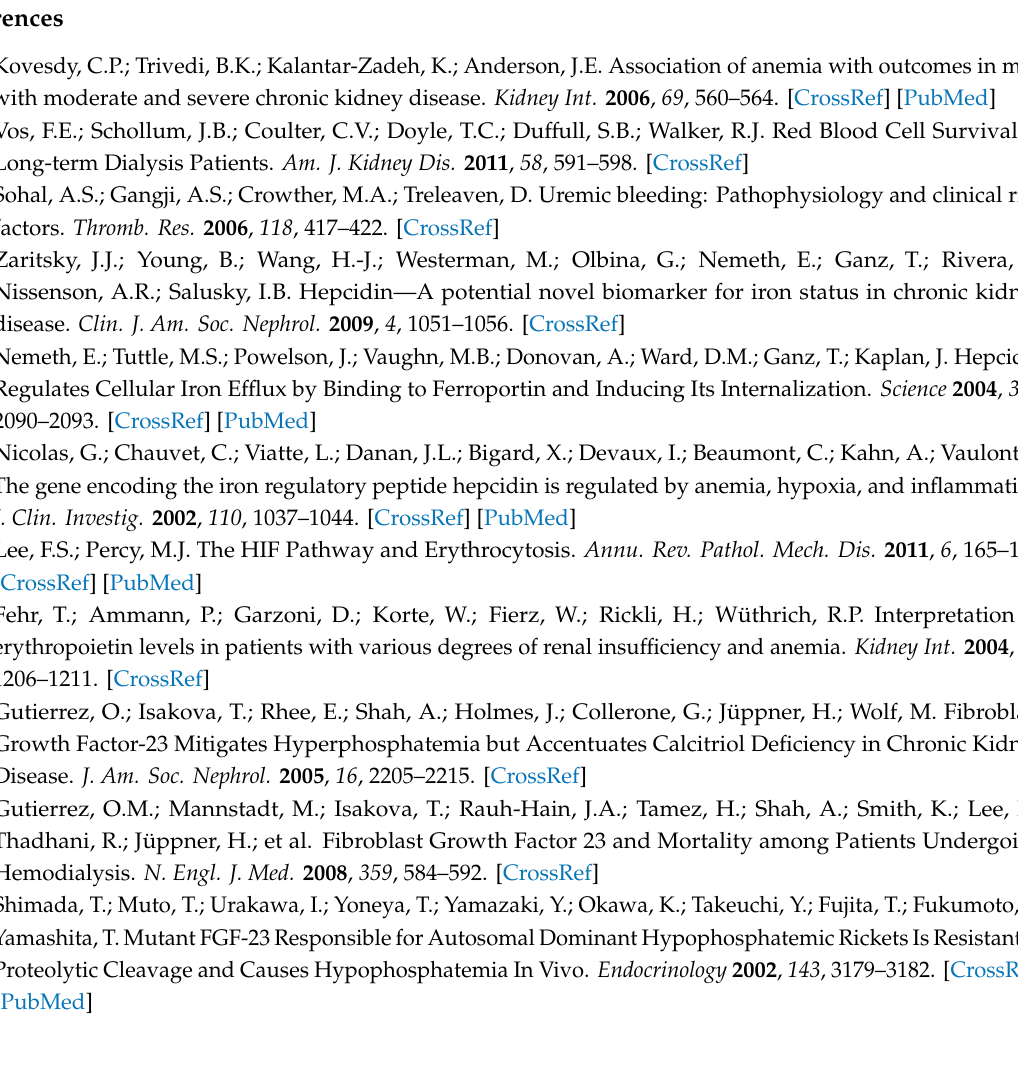
Figure S1: Patient disposition.; Table S1: Total sample number per variable (excluding missing values); Table S2: Influence of phosphate and total calcium on hemoglobin after adjusting for biomarkers of iron metabolism, EPO concentrations, and inflammation biomarkers; Table S3: Influence of phosphate and total calcium on biomarkers of iron metabolism, EPO concentrations, and inflammation biomarkers; Table S4: Influence of cFGF23, iFGF23, phosphate, and total calcium on mean corpuscular hemoglobin (MCH) after adjusting for biomarkers of iron metabolism, EPO concentrations, and inflammation biomarkers; Table S5: Influence of cFGF23, iFGF23, phosphate, and total calcium on mean corpuscular volume (MCV) after adjusting for biomarkers of iron metabolism, EPO concentrations, and inflammation